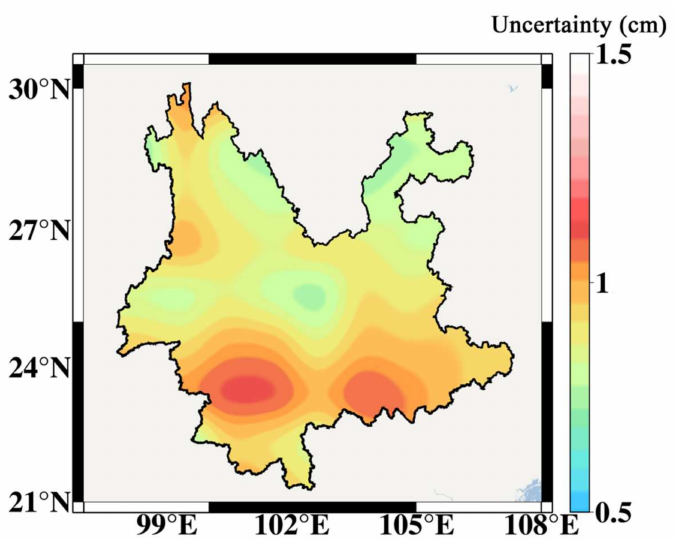
Figure 3. The spatial distribution of uncertainties of TWSC results derived from fusion model.